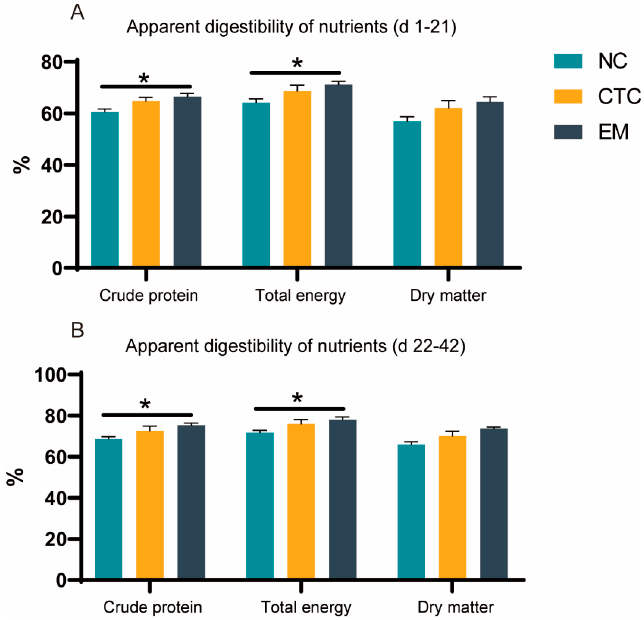
Figure 2. Effects of CTC and EM on the apparent intestinal absorption of crude protein, total